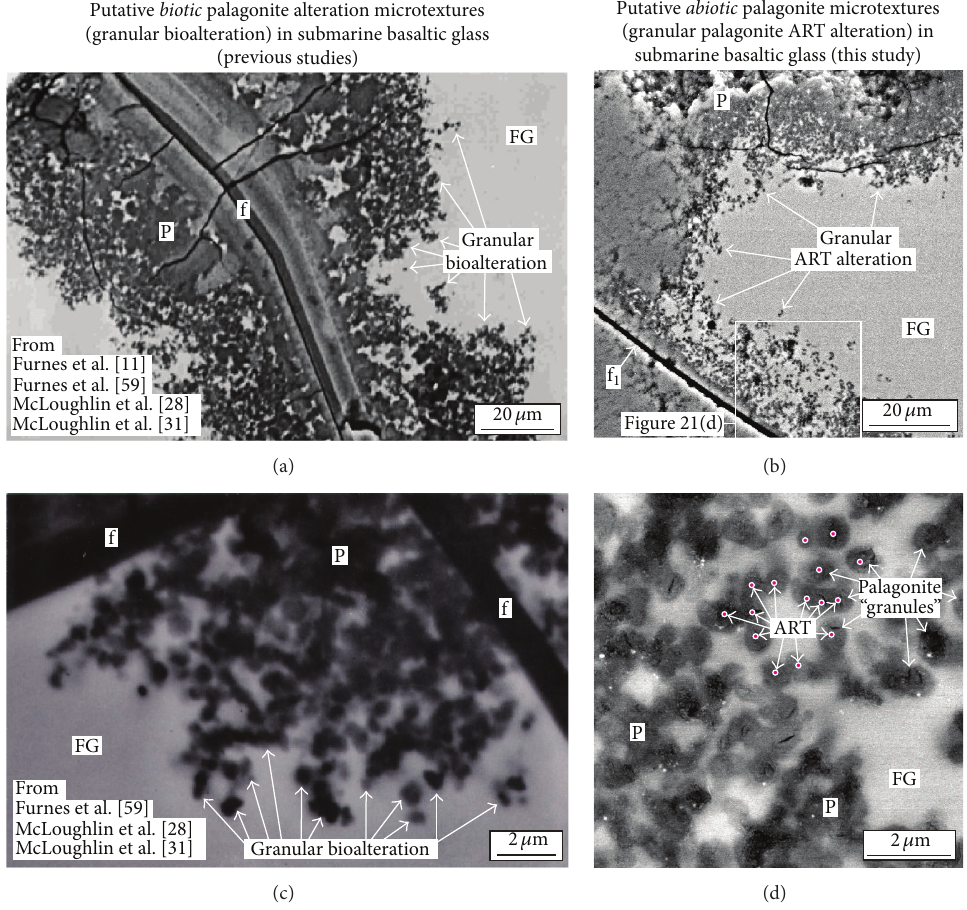
Figure 2: Approximate scale comparisons (near ∼ 1: 1) of previously reported “granular” bioalteration microtextures in submarine basaltic glass (a, c) with abiotic corrosion microtextures (granular palagonite ART alteration) in DSDP 418A basaltic glass (b, d) (this study; sample DSDP-418A-68-3[40–43] ). All images are BSE images (acquired by SEM) of polished petrographic sections of submarine basaltic glasses. (a) is either from sample DSDP-417D-30-6-[20–24] (as reported in Figure 1(e) of [11]) or sample DSDP-418A-62-4-[64–70] (as reported in Figure 5(e) of [31] and Figure 2(c) of [28]), and (c) is from sample DSDP-504b-4-2-[0–20] (as reported in Figure 3(b) of [59], Figure 5(f) of [31], and Figure 2(d) of [28]). Note the similarities when comparing (a) and (c) with (b) and (d), respectively, despite the differences in their inferred origin (biotic versus abiotic). The 120 nm diameter pink circles in (d) correspond to “hypothetical” previously existing alpha-recoil tracks that have undergone selective palagonitization resulting in the formation of palagonite “granules” (or “granular” palagonite texture). ART: alpha-recoil track; f: fracture; f 1 : early fracture; P: